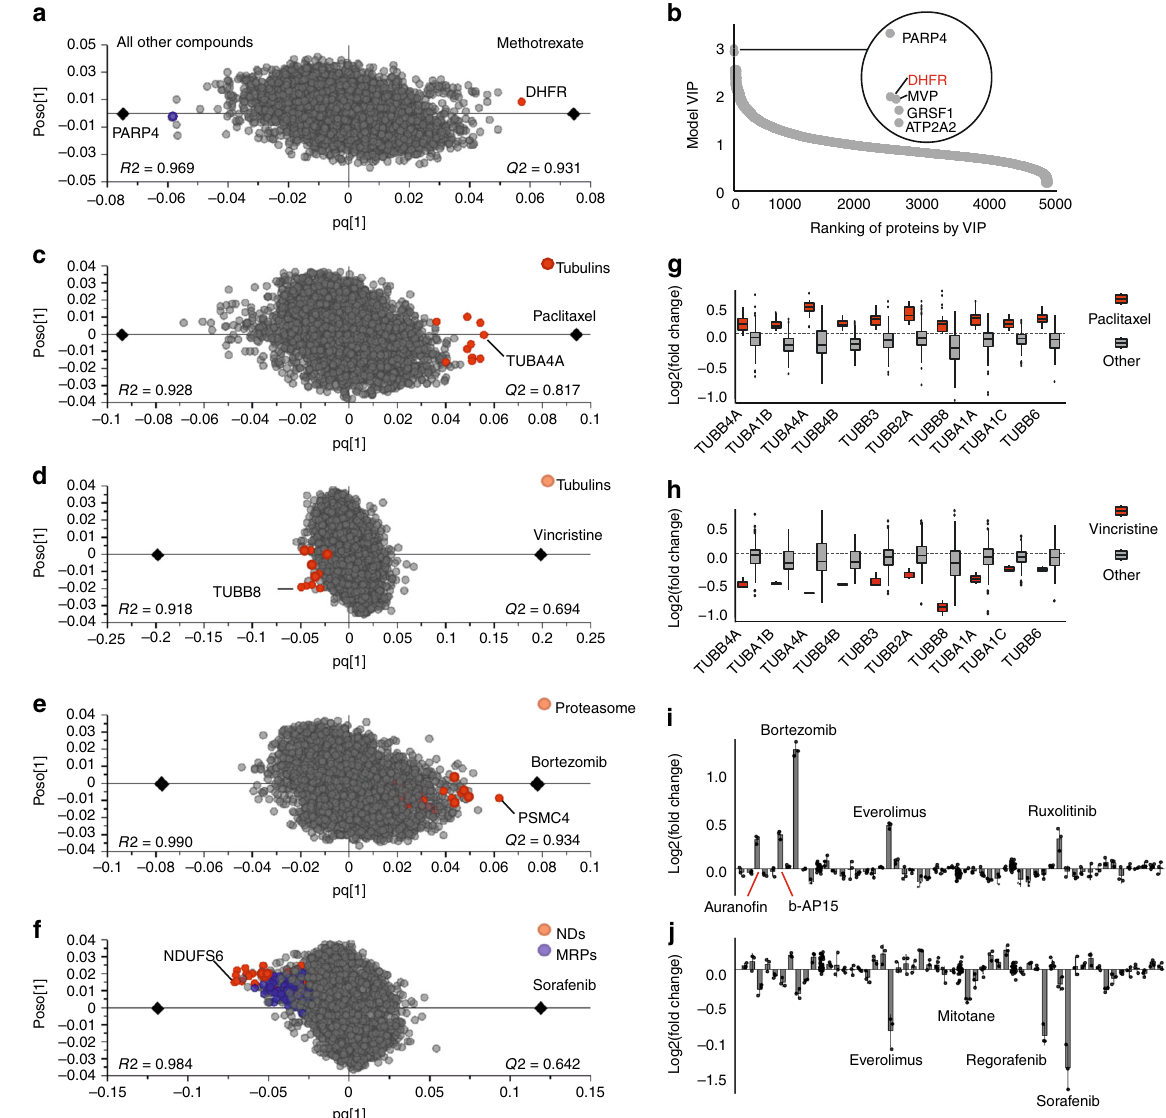
Fig. 4 ProTargetMiner reveals drug targets, action mechanisms, and affected cellular complexes. a OPLS-DA model for methotrexate. b variable in fl uence on projection (VIP) values extracted from methotrexate OPLS-DA model. c – f OPLS-DA models for four other representative compounds (drug targets and/or mechanistic proteins are shown in red and dark blue circles). The mechanistically relevant pathway enrichment for the 30 most speci fi cally up- or down-regulated proteins: GO processes for paclitaxel - mitotic cell cycle ( p < 9E-11) and microtubule-based process ( p < 8E-8); vincristine - mitotic cell cycle ( p < 1E-5) and microtubule cytoskeleton organization (p < 2E-4). Microtubule was the top enriched component for both paclitaxel and vincristine ( p < 0.001). Proteasome complex ( p < 4E-7) and NADH dehydrogenase complex (in red, p < 7E-21) were the top components enriched for bortezomib and sorafenib, respectively. Mitochondrial translation processes (in blue, p < 0.001) were also enriched in GO terms for sorafenib (selection of 30 top proteins in either side of x axis is empirical and leads to less redundancy in pathways). MRP = mitochondrial ribosomal proteins, ND = NADH dehydrogenase. g the regulation of tubulins in response to paclitaxel vs. control in comparison with all other compounds. h the regulation of tubulins in response to vincristine vs. control in comparison with all other compounds (Center line, median; box limits contain 50%; upper and lower quartiles, 75 and 25%; maximum, greatest value excluding outliers; minimum, least value excluding outliers; outliers, more than 1.5 times of upper and lower quartiles). i the regulation of PSMC4 in response to bortezomib vs. control in comparison with all other compounds. j the regulation of NDUFS6 in response to sorafenib vs. control in comparison with all other compounds. Data are represented as mean ± s.d. ( n ≥ 3 biologically independent experiments). Panels a and c – f were made from Supplementary Data 1). Source data are provided as a Source Data fi